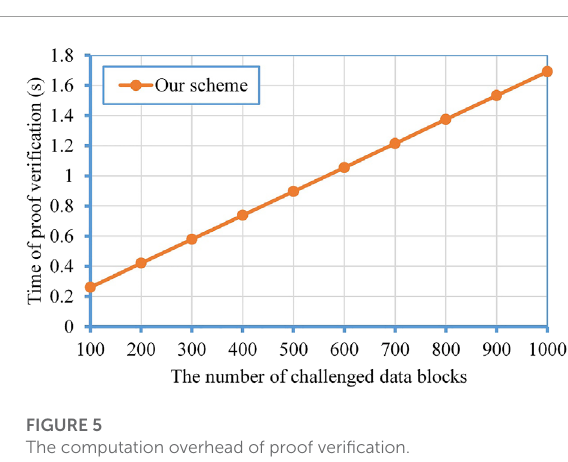
FIGURE 5 The computation overhead of proof